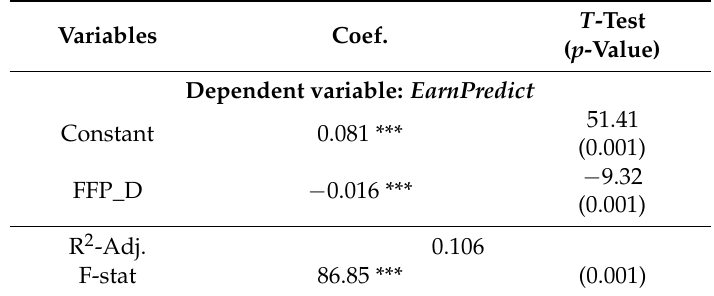
Table 4. Earnings predictability during FFP regulation.